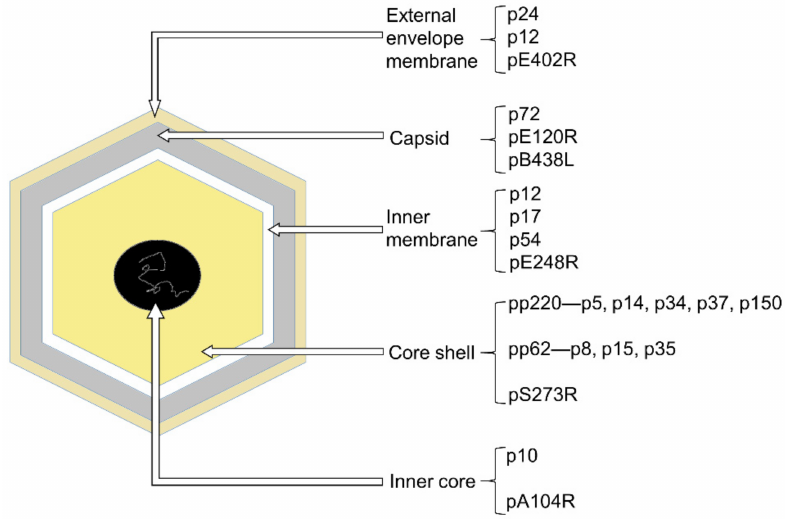
Figure 1. Illustration of ASFV particle and examples of proteins in each layer. The ASFV is composed of five layers: the external envelope membrane (pale-yellow), the capsid (gray), the inner membrane (white), the core shell (yellow), and the inner core